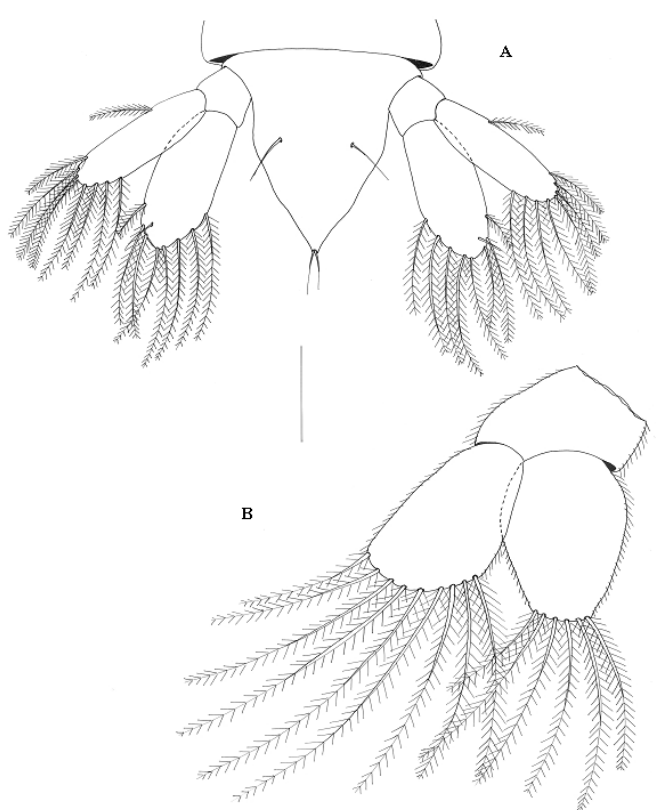
Fig. 2 – Praniza larvae collected from fishes of estuarine zone of Northeast of Pará, Brazil. A: Telson and uropods with setae. B: Right pleopod. Bar = 75 μ m.